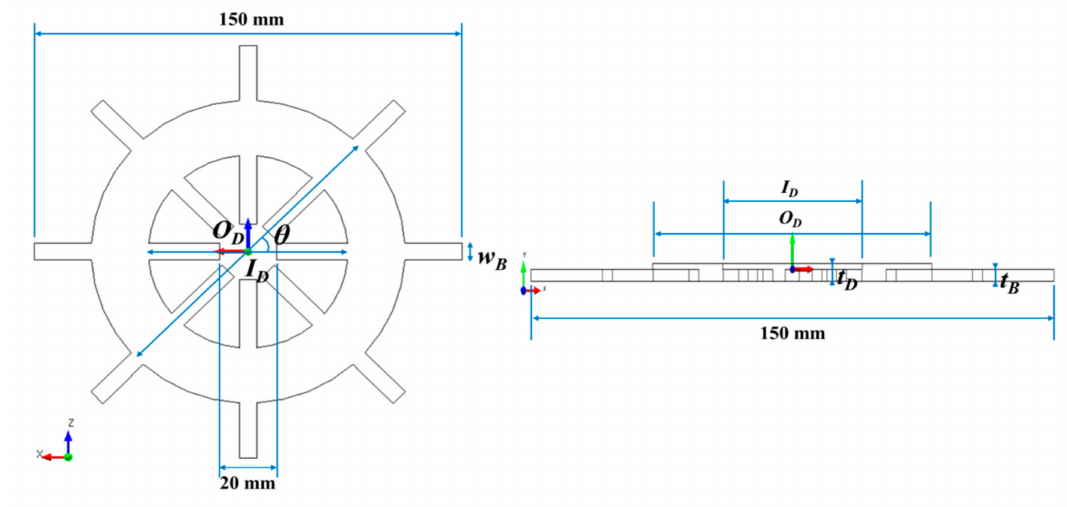
Figure 11. Geometric parameters for shape optimization of the circular bar